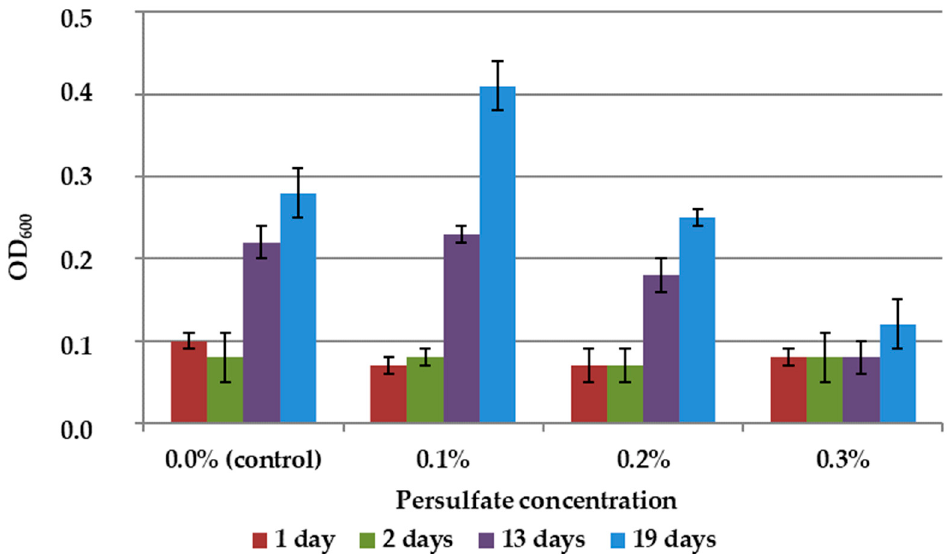
Figure 5. Growth dynamics of A. ferrooxidans TFBk culture in 9K medium with various persulfate concentrations. The y-axis shows the optical density of the medium with bacteria.